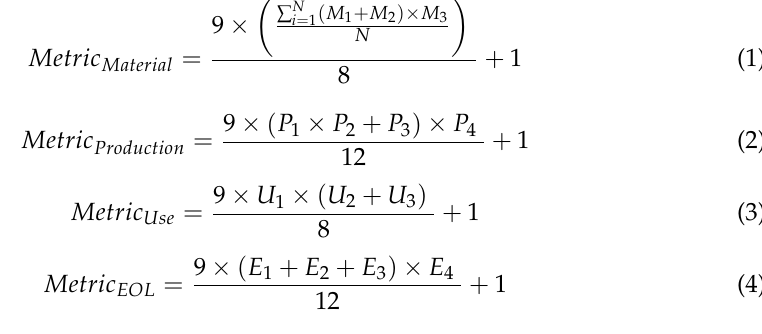
Table 5. Evaluation of each metric measurement relating to mobile